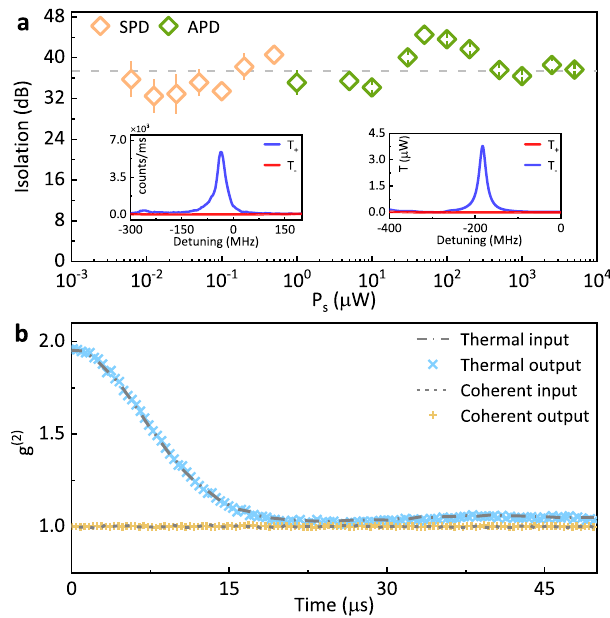
Fig. 5 The dynamic range and noiseless property of the all-optical isolation. a The measured isolation ratios against input signal power ( P s ). Due to the limitation of the system insertion loss and detector ’ s response, avalanche photodetectors (APDs) are adapted for P s ≥ 1 μ W (shown as green spots) and a single-photon detector (SPD) is used for P s < 1 μ W (shown as orange spots). The insets are two typical spectra measured for P s = 6.25 nW (left) and 1.2 mW (right), respectively. b Measured second- order correlation function (g (2) ) for signal input to and output from the device. Blue crosses and dashed line are the results for pseudo-thermal source, while yellow crosses and dotted line are the results for coherent source. In all studies, the drive power is set at 50 mW, vapor temperature is 65 ∘ C, and error bars denote standard deviations. Table 1 Comparison with other representative experimental demonstrations of the magnetic-free optical isolator. The table compares our devices with other state-of-the-art devices, in terms of platform, principle, max isolation ratio, 3 dB forward transmission bandwidth, 20 dB isolation bandwidth, and insertion loss. PIC: photonic integrated circuits, EIT: electromagnetically-induced transparency, OIM: optically-induced magnetization. The symbol * indicates that the value is derived based on the reported experimental